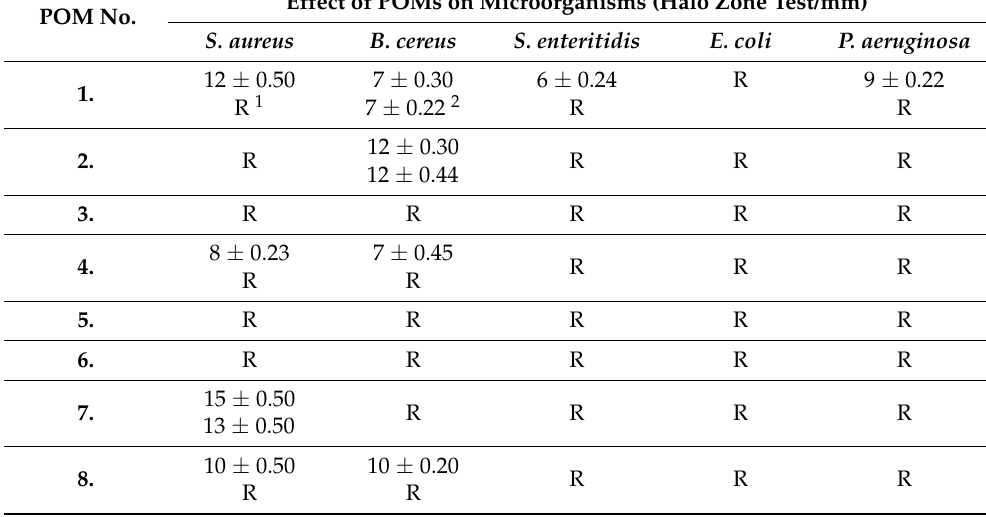
Table 3. POM antibacterial activity as measured by the disk diffusion method. POM